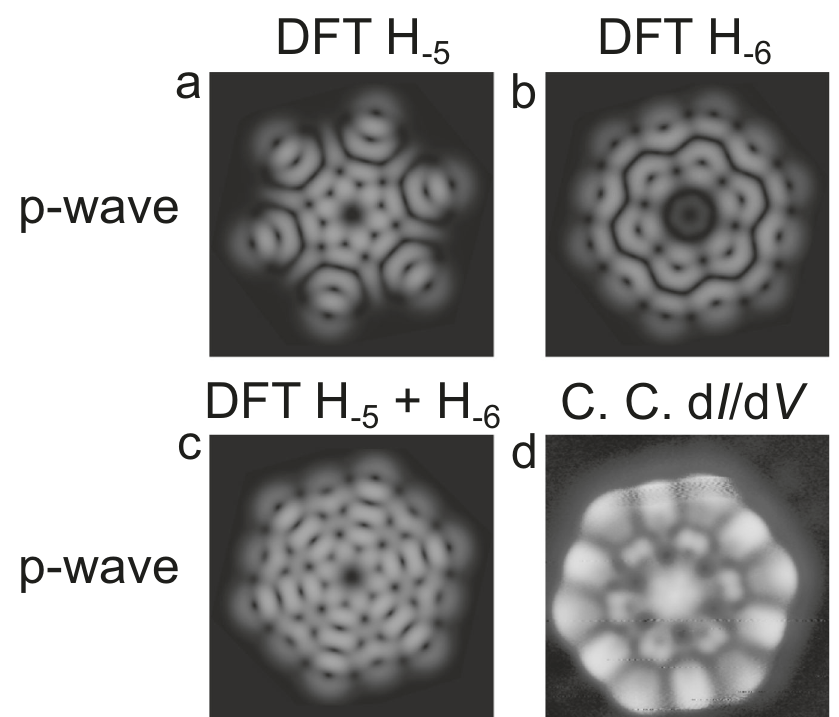
Fig. 4 Calculated gas-phase p-wave molecular orbitals and constant-current d I /d V maps of C108 obtained with a CO tip of PIR 3 . a , b Visualization of the molecular wavefunctions as calculated by DFT using a p-wave tip of H − 5 = − 1.964 eV and H -6 = − 2.019 and the sum of H − 5 and H -6 ( c ). d Constant- current d I /d V map performed with CO tip at the bias voltage V PIR3 = − 1.95 V and current setpoint of I PIR3 = 40 nA, with V mod = 10 mV. Image sizes are 2.5 × 2.5 nm 2